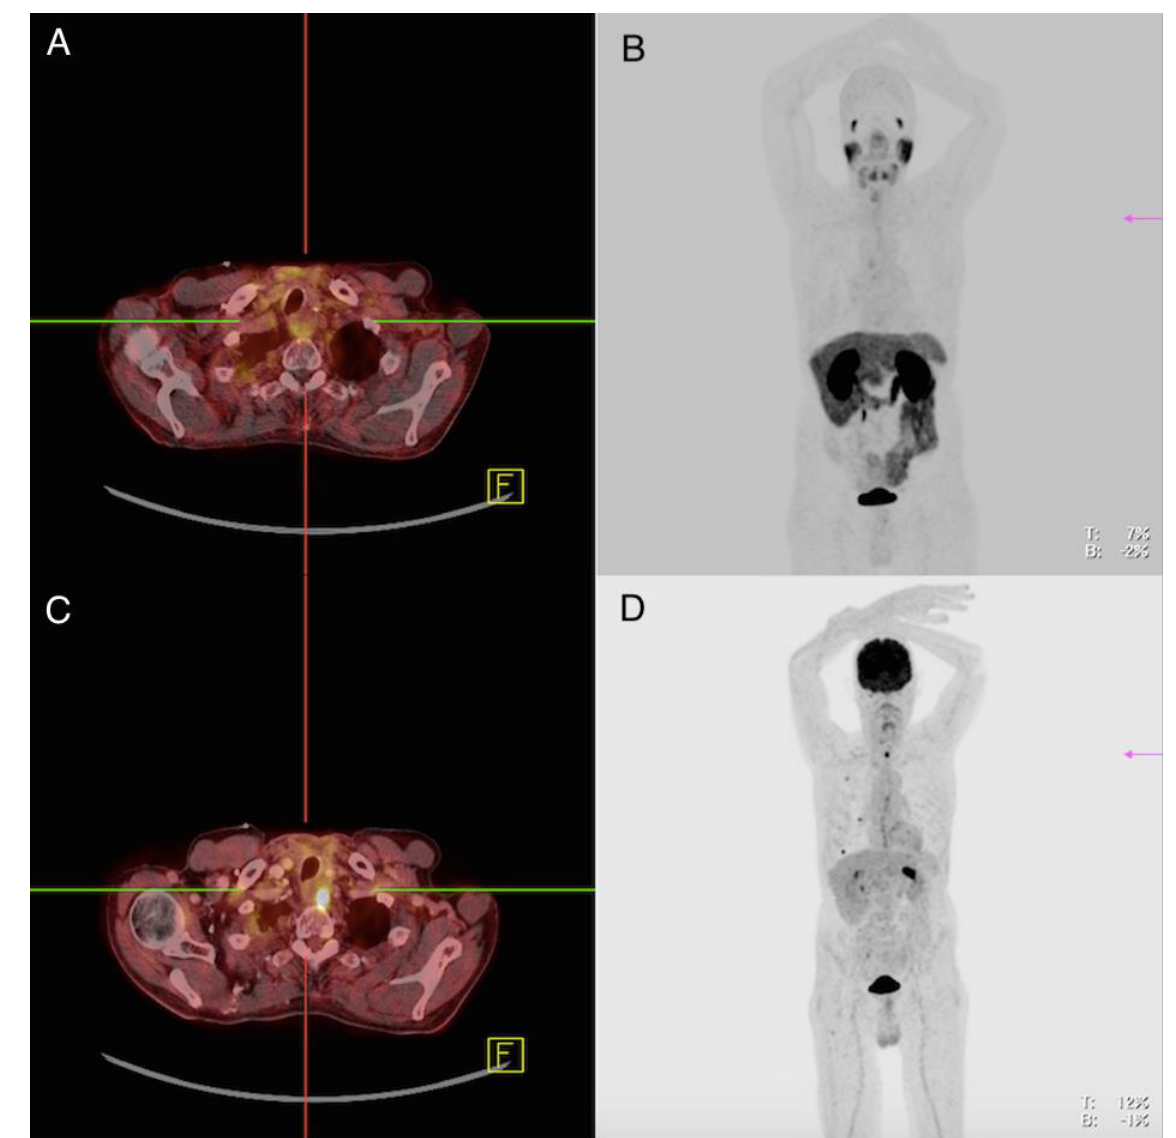
Figure 1. Patient 1. 68 Ga-PSMA-PET/CT ( A , B ), 18 FDG-PET/CT ( C , D ). The finding was compatible with a local recurrence in the left thyroid bed. The FDG-positive lesion showed no PSMA expression.